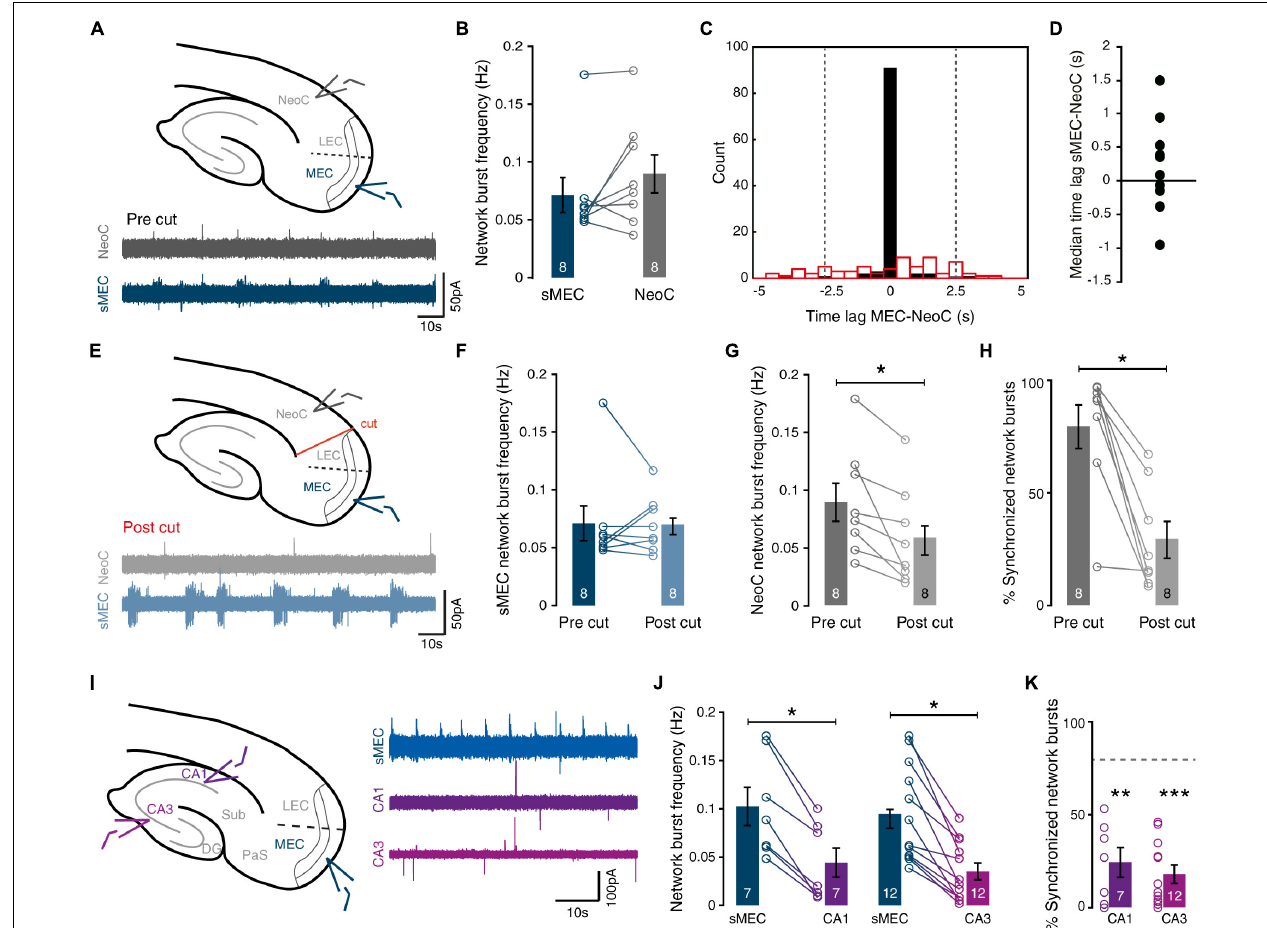
FIGURE 3 | Spontaneous network activity in immature MEC synchronizes network activity in neocortex. (A) Top: Schematic view of field recordings. Bottom: Example traces of simultaneous recordings from sMEC (blue) and superficial neocortex (NeoC, gray). (B) Network burst frequency is similar between sMEC and NeoC [paired t (7) = 1.58, p = 0.157]. (C) Representative time-lag histogram for onset times of network bursts between sMEC and NeoC pre- (black bars) and post-lesion (red open bars, see E ). All bursts with a time lag within ± 2.5 s (between gray dotted lines) are considered synchronized. (D) No reliable time-lag [one-sample t (9) = 1.06, p = 0.317] indicating no directionality of activity between sMEC and NeoC. (E) Top: Schematic view of field recordings and lesion site. Bottom: Example traces of simultaneous recordings from sMEC (blue) and superficial neocortex (NeoC, gray) after lesion (“post cut”). (F) No change in the frequency of sMEC network bursts following lesion [paired t (7) = 0.10, p = 0.923]. (G) Lesion decreased the frequency of NeoC network bursts [paired t (7) = 3.19, p = 0.015]. (H) Decrease in synchronized bursts between sMEC and NeoC after lesion [paired t (7) = 5.10, p = 0.001]. (I) Left: field recording sites (CA1, CA3, sMEC). Right: example traces of simultaneous recordings. (J) Network burst frequencies are lower in CA1 and CA3 than in sMEC [CA1: paired t (6) = 6.95, p < 0.001. CA3: paired t (11) = 6.12, p < 0.001]. (K) Levels of synchrony between CA1-sMEC and CA3-sMEC are significantly weaker than sMEC-NeoC (gray dashed line) [CA1-sMEC